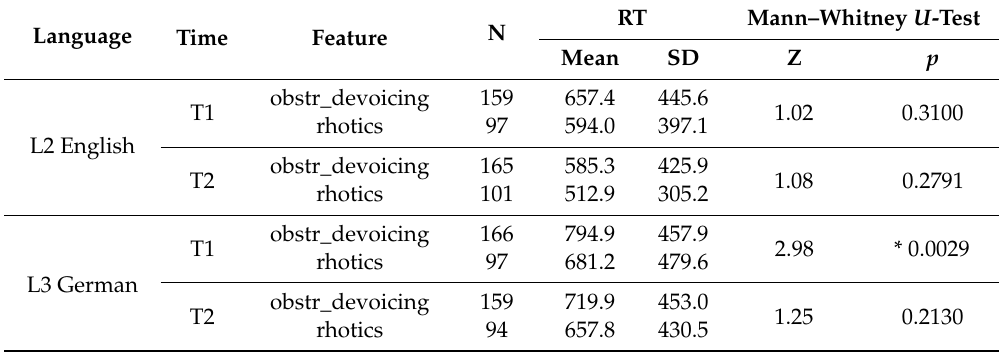
Table 6. Comparison of RT to features at T1 and